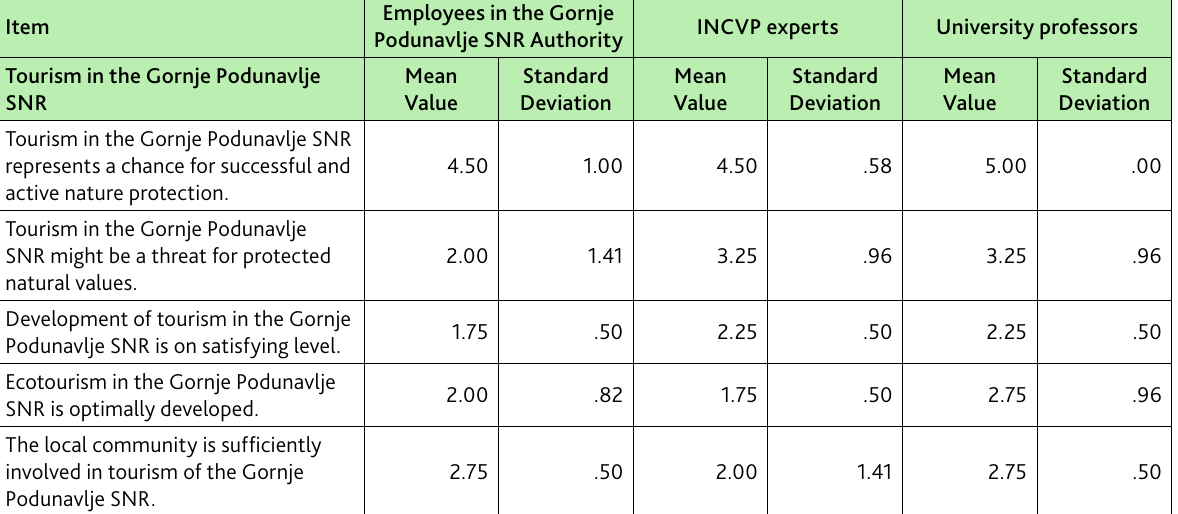
Table 2. Respondents’ attitudes on tourism in the Gornje Podunavlje SNR